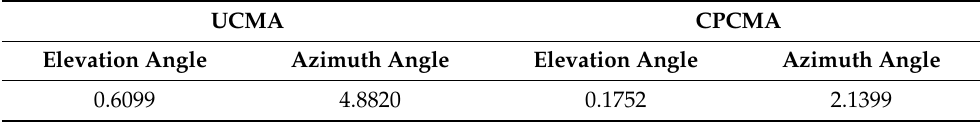
Table 5. Root-mean-square error (RMSE) in outer race defect locatied by both arrays at 290 rpm. UCMA CPCMA